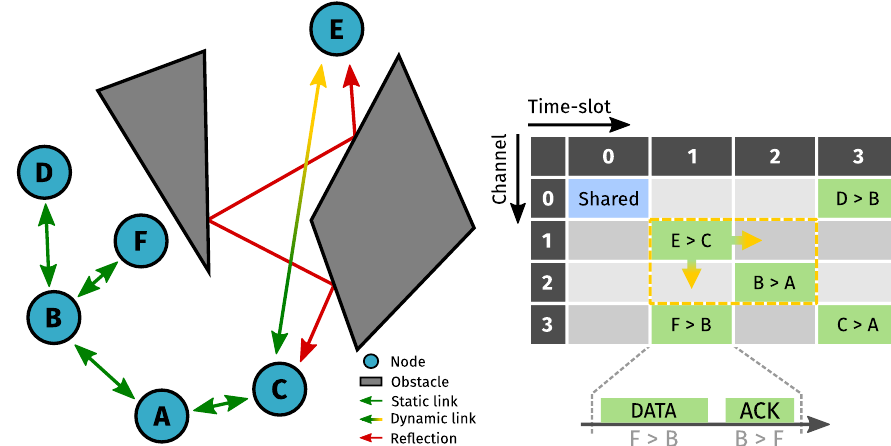
Figure 1. Example of a small Time Slotted Channel Hopping (TSCH) network. Due to multi-path fading, the dynamic link between nodes E and C may revert to a modulation scheme with lower data-rate and wider bandwidth, causing the link to expand into the time/frequency space of adjacent slots. Note this figure does not represent a schedule, but rather its result in time and